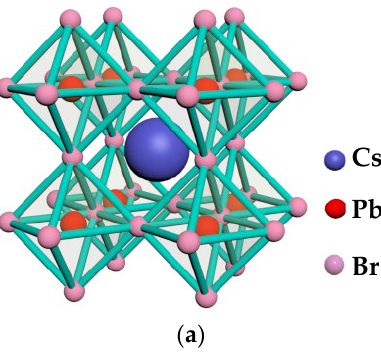
Figure 1. The crystal structures of CsPbBr 3 and the schematic drawing of FTO/CsPbBr 3 /Al vertical stack structure for the memory. ( a ) The crystal structures of CsPbBr 3 ; ( b ) the schematic drawing of FTO/CsPbBr 3 /Al vertical stack structure for the memory.